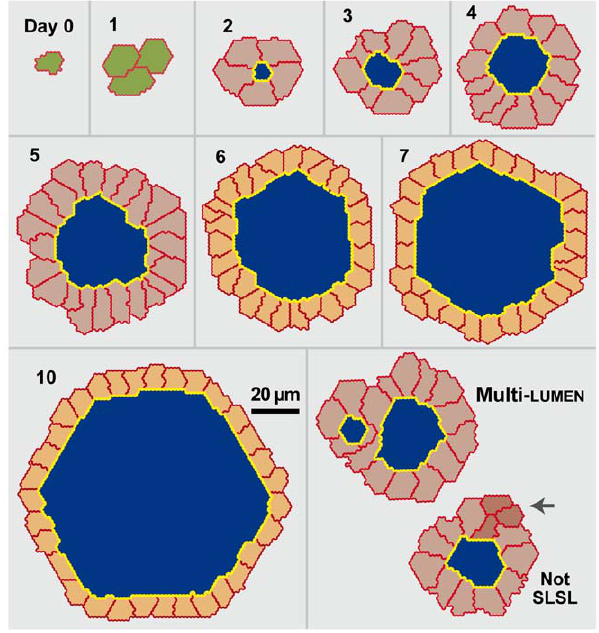
Figure 4. In silico MDCK analogue CYST cross sections. Note that a regular hexagon in hexagonal space maps to a circle in continuous space. Images are from a single simulation run using parameter settings from Table 2. C ELLS are UNPOLARIZED (green), POLARIZED (gray) or stabilized (orange). C ELL - CELL and CELL - MATRIX borders are red; CELL - LUMEN borders are yellow; LUMENS are blue. Lower right panel: shown is a multi- LUMEN CYST . Not SLSL: this single LUMEN CYST does not have a single layer of CELLS . The arrow indicates two CELLS not in contact with LUMEN .